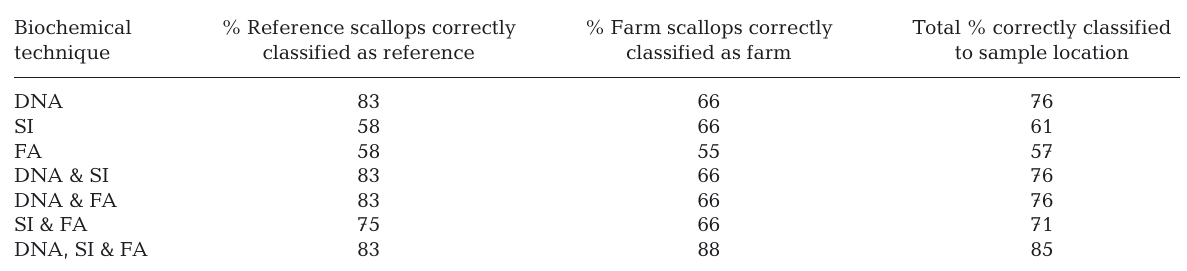
Table 7. Comparison of using single or multiple biochemical techniques to determine the correct sampling location of king scallops Pecten maximus based on digestive tissue. SI: stable isotopes; FA: fatty acids (terrestrial